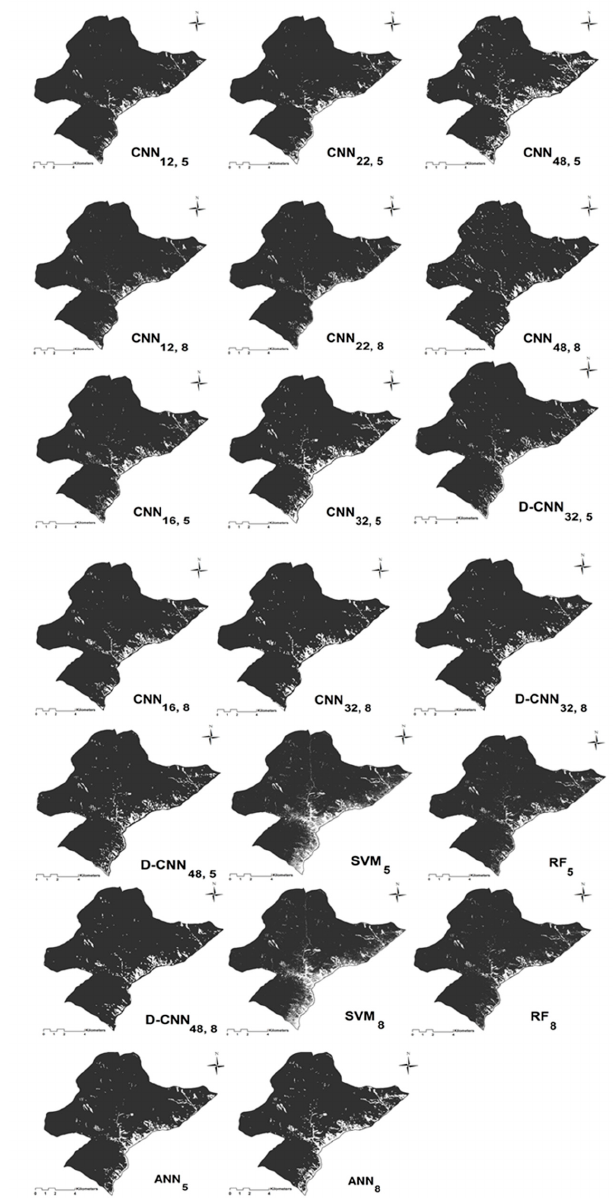
Figure 7. Landslide detection results using different ML and CNN methods, training datasets and parameters. In any CNN p,q and ML q the index of p corresponds to the size of the convolution input window, and q indicates the number of input layers that were used for training.